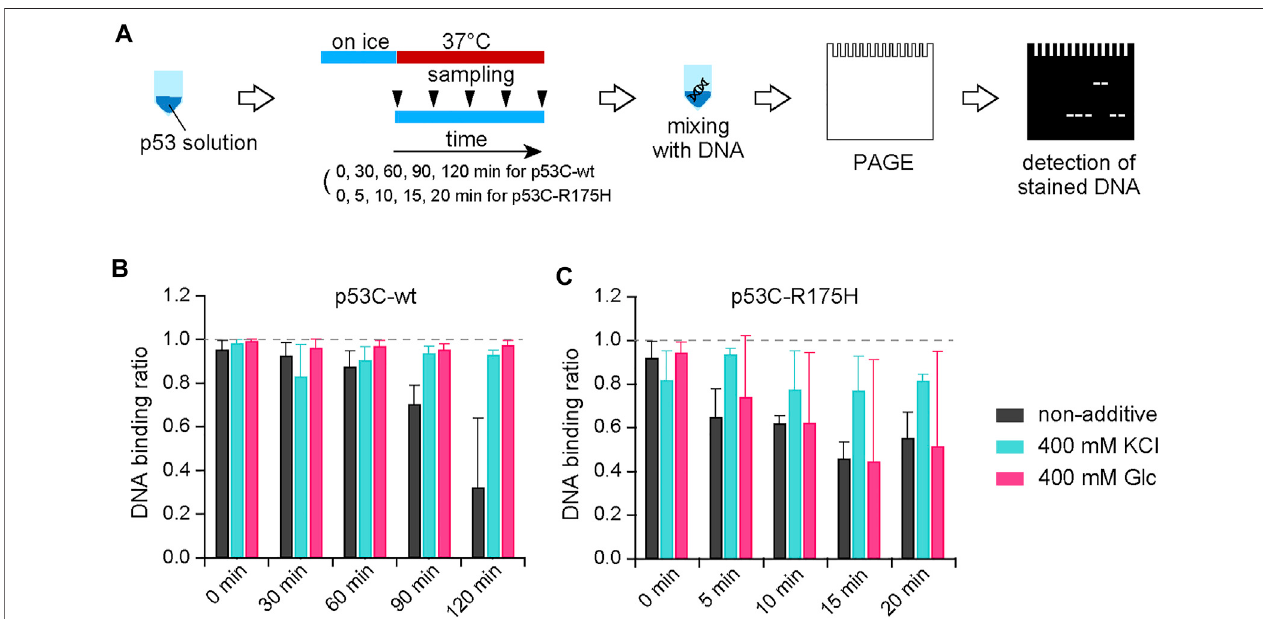
FIGURE 3 | (A) Schematic diagram of the experimental procedure for the gel shift assay using p53 and DNA. (B,C) The unbound fraction was calculated from the intensity of the band at the location of the DNA without the protein solution and normalized to 1 for bound DNA and 0 for unbound DNA.